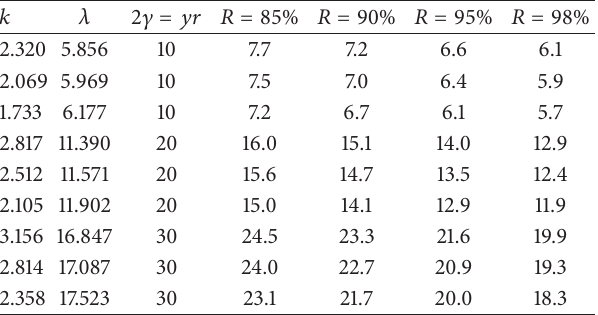
Table 2: Reliable life ( 𝑌𝑟 𝑅 ) for different parameters of survival